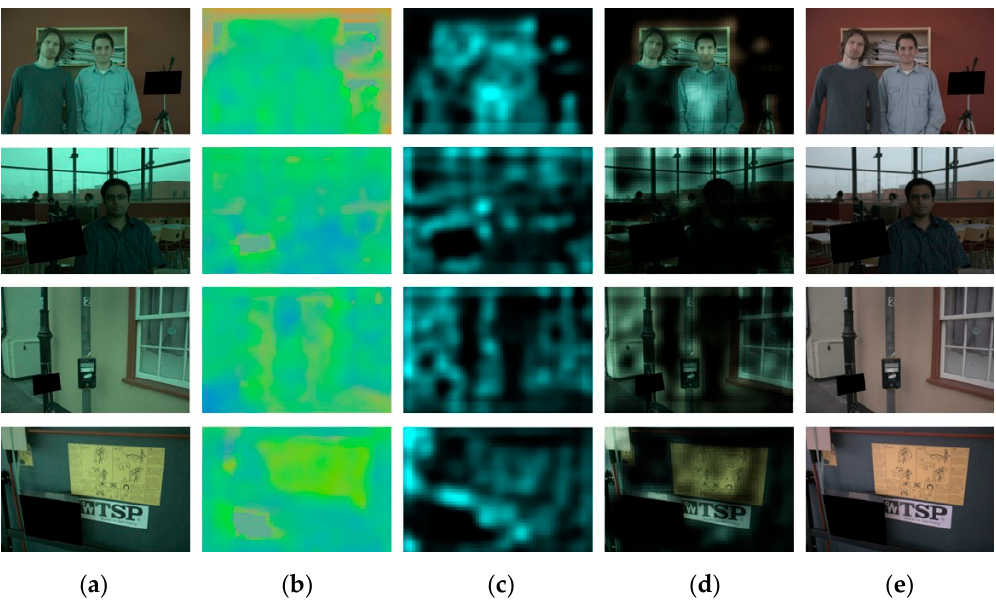
Figure 5. Shi’s re-processed dataset and their resulting images: ( a ) original image, ( b ) illumination estimation map, ( c ) weighted map, ( d ) image × weighted map, and ( e ) corrected image.